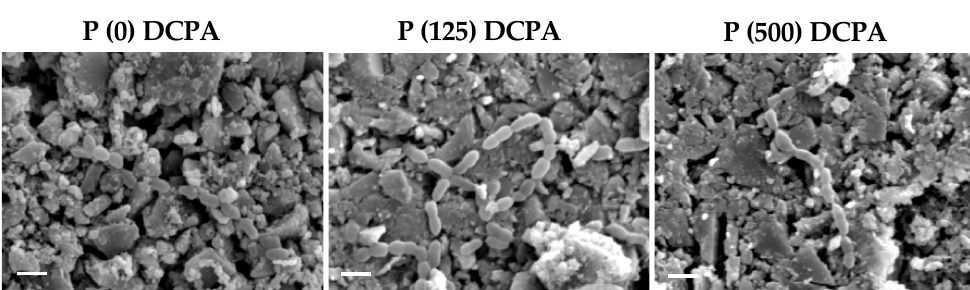
Figure 1. Antimicrobial activity of protamine-loaded DCPA fabricated discs. S. mutans (4 × 10 6 CFU·cm –3 ) were incubated in 1/10 concentration of media with each disc (P (0) DCPA, P (125) DCPA, P (500) DCPA) for 24 h. Error bars indicate standard error of the mean ( n = 3). The asterisks show * P < 0.05, ** P < 0.01 by Student’s t -test. ( A ) The bacteria attached to the surface of each disc were stained with SYTO ® 9 and PI. Live bacteria appear green and dead bacteria appear red. Bars represent 20 μ m. ( B ) The area stained by SYTO ® 9 and PI was analyzed by image analysis. This figure indicates the ratio of dead bacteria to live bacteria. ( C ) SEM images of the bacteria attached to each disc surface. Bars represent 1.0 μ m.